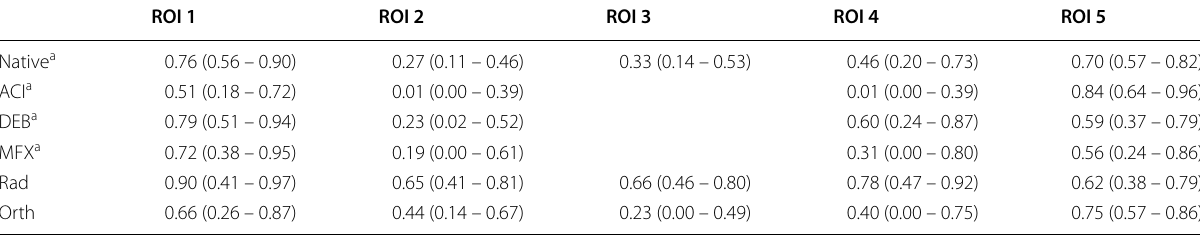
Overall interobserver agreement ( a ) for T2 measurements of native cartilage, ACI (Autologous Chondrocyte Implantation, DEB (Debridem ent) and MFX (Microfracture) ROI (Region of interest) 1 and 2: sagittal plane, medial and lateral condyles, respectively. ROI 3: mid-sagittal, patella. ROI 4 and 5: coronal plane, medial and lateral condyles, respectively. Interobserver agreement for radiologists (Rad.) and orthopaedic surgeons (Orth.) is presented in the two lower